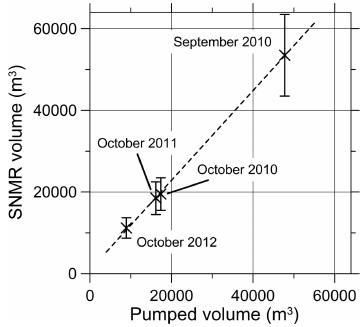
Fig. 6. Amplitude of the SNMR signal vs. pulse moment measured with loop no. 1. Circles show the amplitude measured in 2009 when the cavern was undisturbed by pumping ( V = 53500m 3 ) , crosses correspond to 2011 data ( V = 18500m 3 ) and squares are 2012 measurements ( V = 11200m 3 ) . Triangles show measurements of the ambient electromagnetic noise.